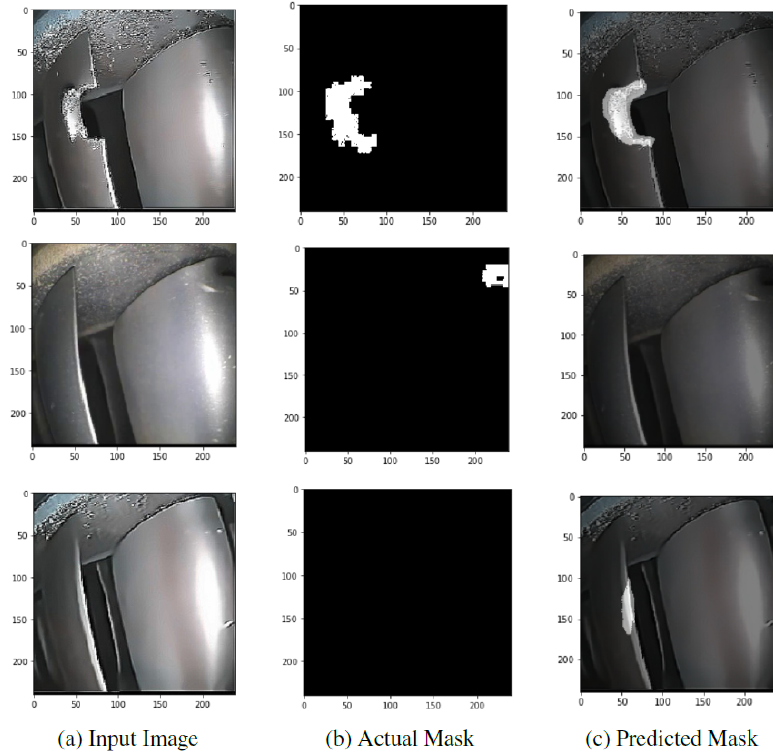
Figure A1. BCE segmentation on test data after 50 epochs.